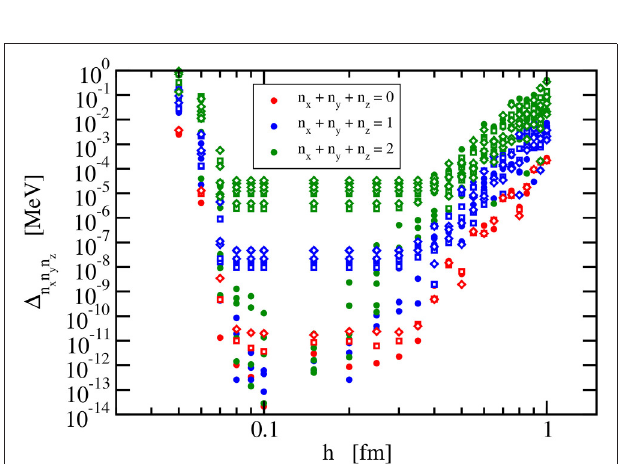
FIGURE 4 | Deviation (88) of the calculated lowest energies of a relativistic h ω harmonic oscillator with 20 MeV and m 938 MeV/ c 2 from the exact = = ¯ results for constant scaling factor ( h 0.1 fm) and constant number of = channels ( N c 11). Results are shown as a function of the number of grid = points N for the spherical case (full symbols), prolate deformation with d 0.1 = (open diamonds), and oblate deformation with d 0.1 (open = −